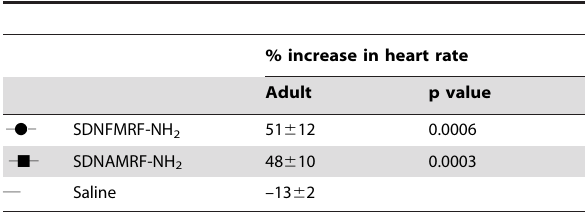
Table 14. Cardioexcitatory effects of a D. melanogaster FMRF- NH 2 analog a, b